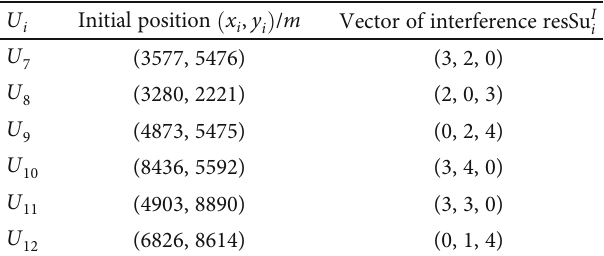
Table 4: The initial state of electronic interference UAVs.